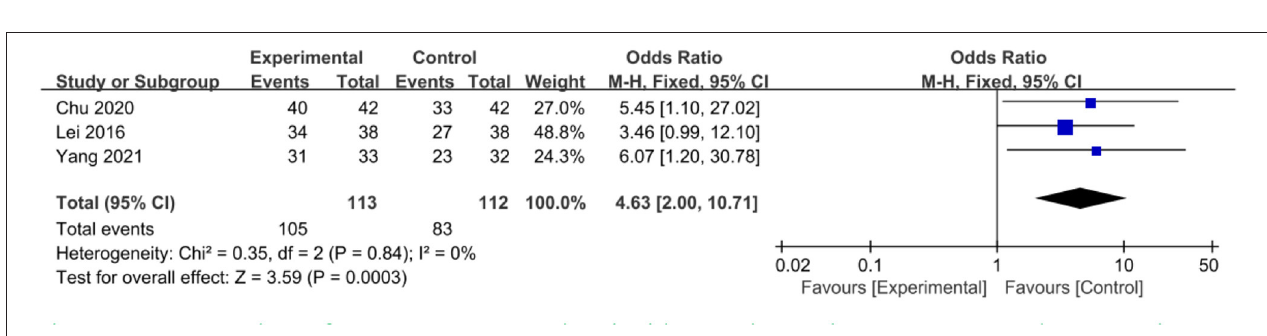
FIGURE 22 | Forest plots of serum amylase recovery time associated with experimental group (parenteral or enteral nutrition group supplemented with Gln) vs. control group (conventional nutrition group). I 2 tests and P are the criteria for the heterogeneity test, (cid:7) , pooled mean difference; — (cid:4) —, mean difference, and the edges of (cid:7) , 95% CI.